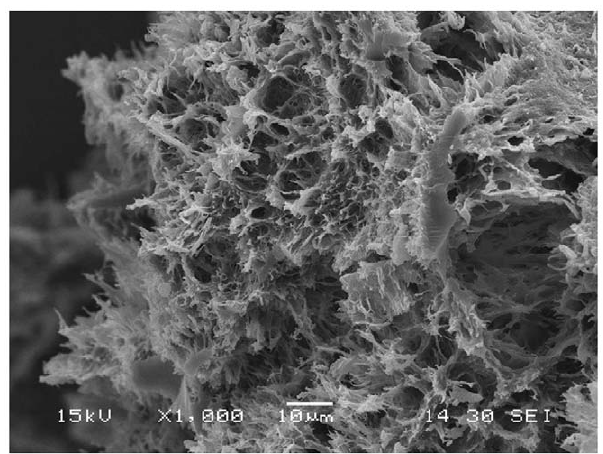
Figure 5. Scanning electron microscope images of lyophilized CLEAs. After gold sputtering, the samples were visualized with a JSM- 6360LV Electron Microscope (JEOL) operated at 15 kV.